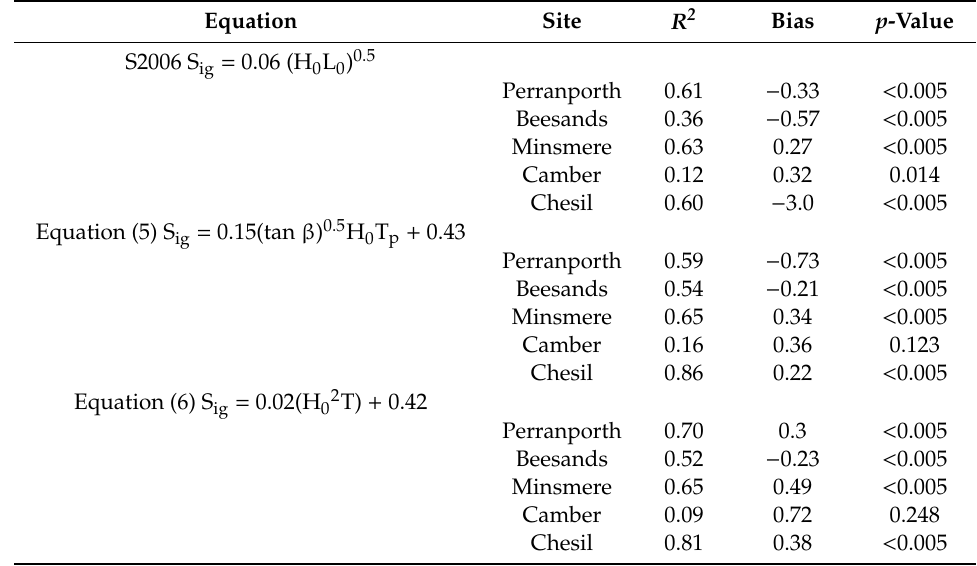
Table 5. Comparison of relationships between observed S ig and S ig predicted by S2006, and Equations (5) and (6). Equation Site R